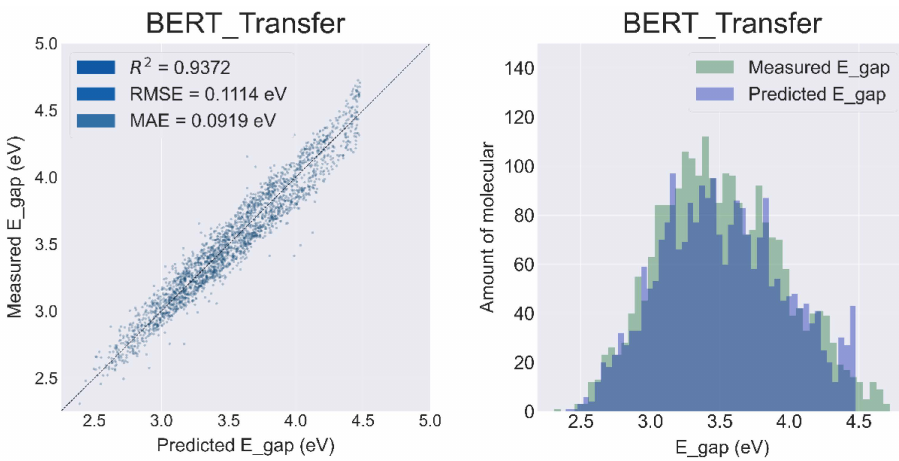
Figure 6. Results of the prediction sets for the BERT Model with transfer